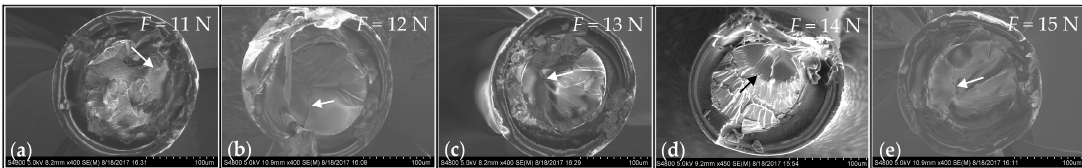
Figure 16. Fracture cross sections under different tensile forces. ( a ) F = 11 N; ( b ) F = 12 N; ( c ) F = 13 N; ( d ) F = 14 N; ( e ) F = 15